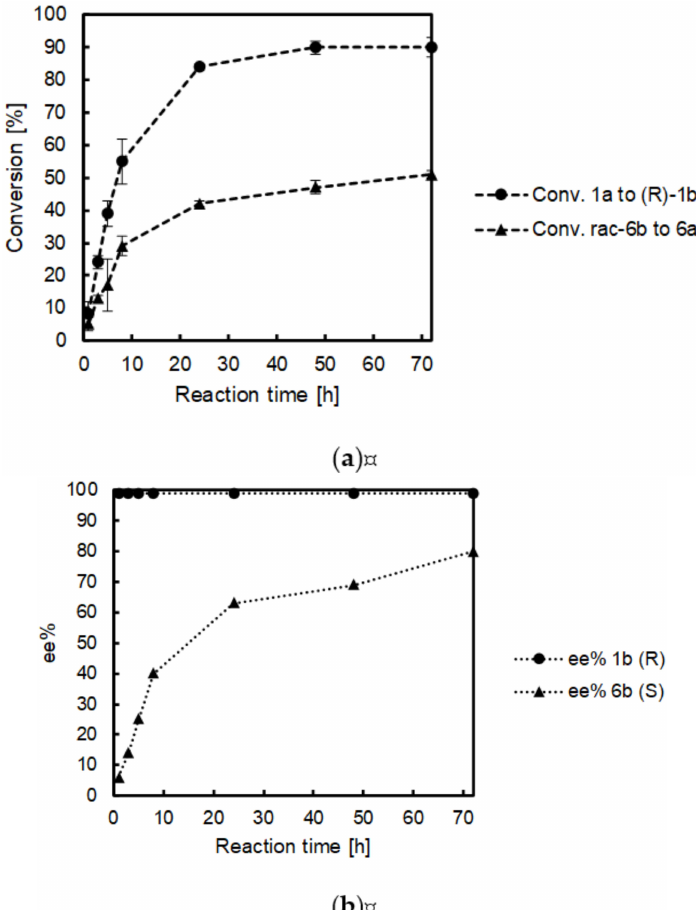
Figure 2. Time study of the PIKAT combining prochiral ketone 1a with racemic amine 6b : ( a ) progress of conversion and ( b ) ee progress over the time. Reaction conditions: toluene (a w = 0.7, reaction volume: 1 mL), 1a (50 mM), rac - 6b (100 mM), immobilized EziG 3 -AsR- ω TA (total mass of enzyme plus carrier material: ca. 22 mg; enzyme loading on carrier material: 10% w w − 1 ), hydrate salt pair (40 mg;